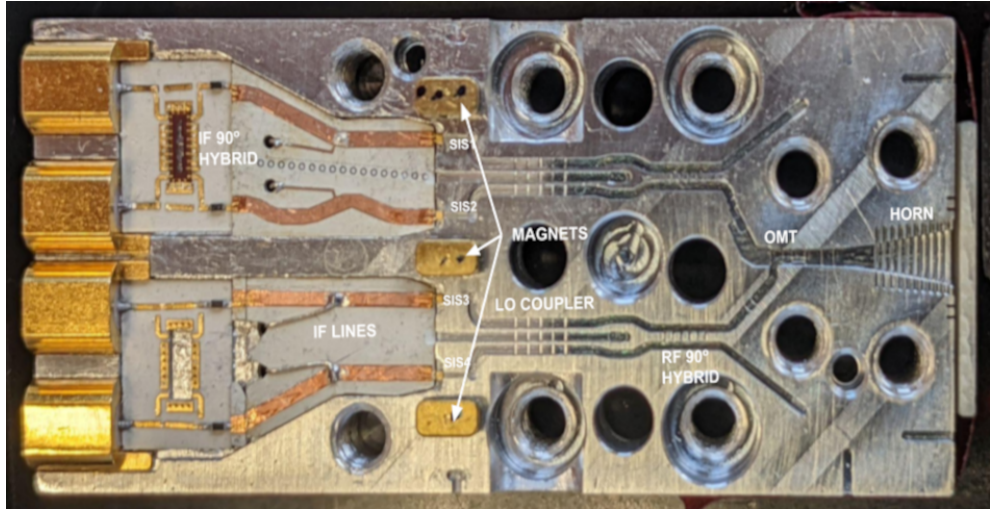
Figure 3. A view of the integrated mixer block for the 1mm receiver. A square section of the corrugated feedhorn feeds into an orthomode transducer (OMT), which splits the two polarizations. Each polarization then enters an RF 90 ◦ hybrid and an LO coupler before going to the SIS mixers. The 4 IF outputs are fed through a IF 90 ◦ hybrid to produce 4 IF outputs, 2 polarizations, and 2 sidebands.